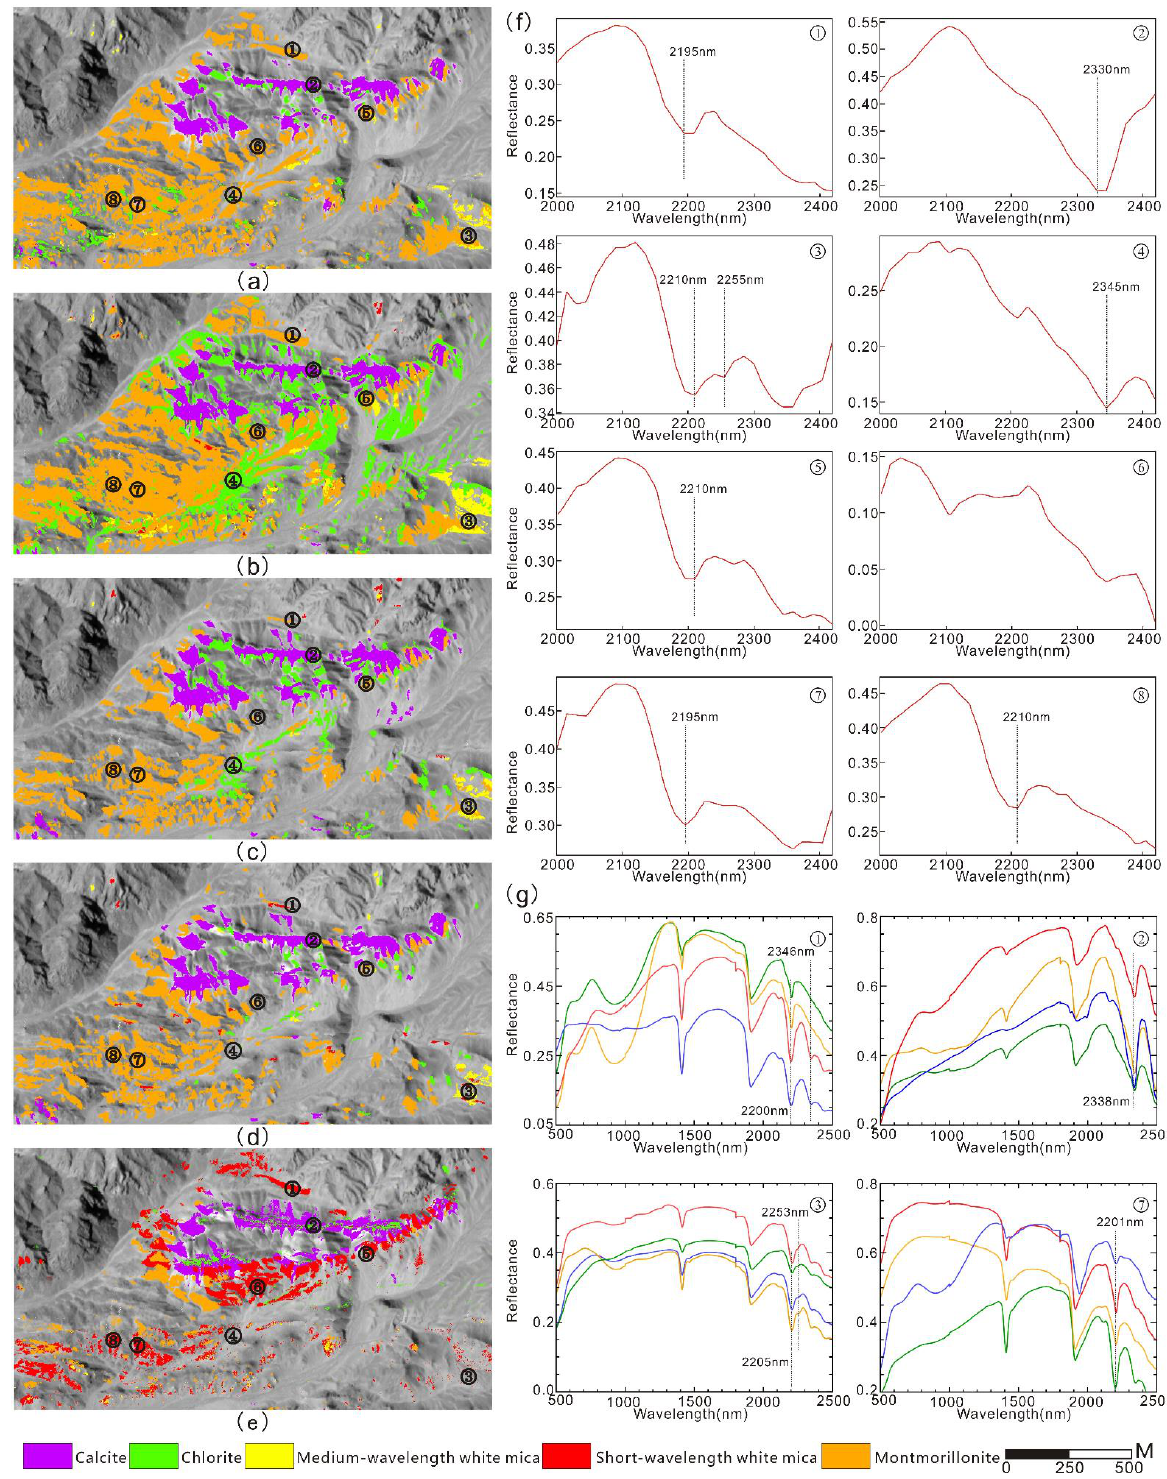
Figure 13. ( a – e ) show the mapping results of the SVM, FCNN, 1D CNN, 1D + 2D CNN models and MTMF in the northwest region of the test area, respectively. ( f ) shows the pixel spectral curves of 8 points numbered 1 (cid:13) – 8 (cid:13) in the SASI images. ( g ) shows the spectral curves of rock samples collected at the corresponding points measured by ASD spectrometer in the laboratory, and curves with different colors represent the measurement results of different rock